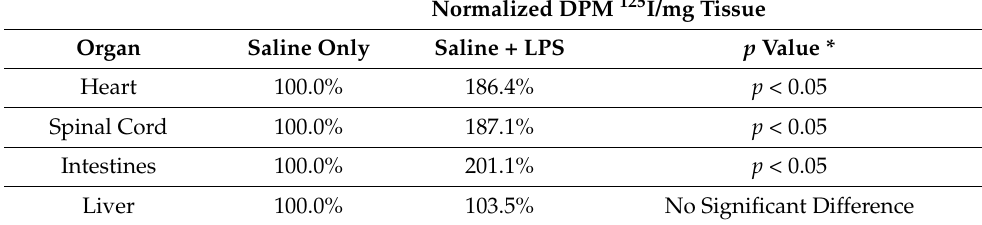
Table 1. Organ Uptake of 125 I-MV-A iNOS After an LPS Challenge in Mice Normalized against Saline